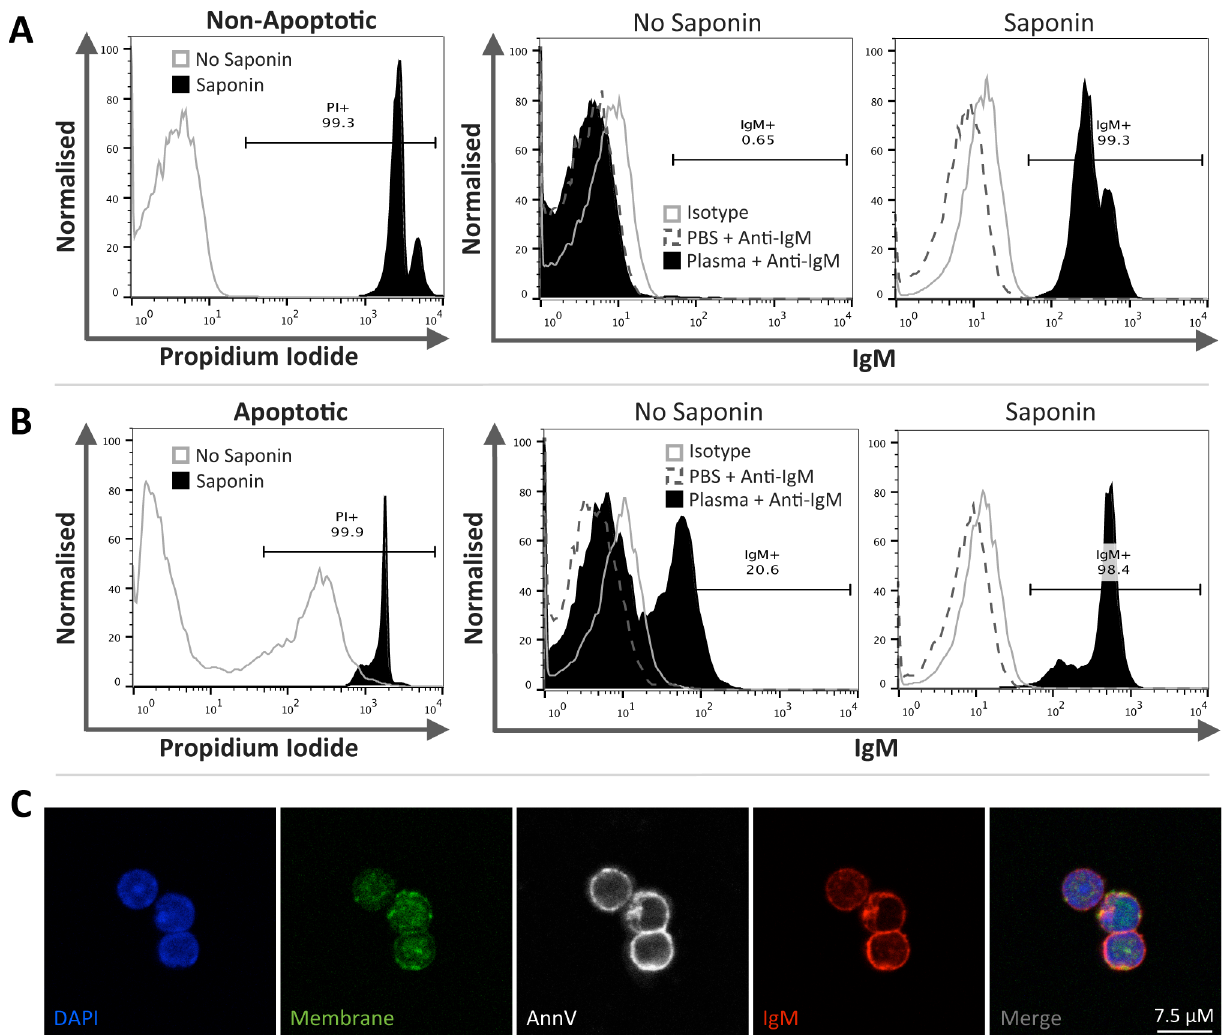
Fig 3. IgM binds strongly to permeabilised non-apoptotic and apoptotic thymocytes. Non-apoptotic and apoptotic mouse thymocytes, induced by overnight culture, were permeabilised with saponin prior to incubation with Balb/c plasma. Permeability was confirmed by PI staining and IgM binding was assessed by flow cytometry. For confocal microscopy AnnV staining was used to indicate permeabilisation A ) Following permeablisation non-apoptotic thymocytes were predominantly PI positive. Non-permeable non-apoptotic thymocytes remained consistently IgM negative, whilst the majority of permeable thymocytes were IgM positive. Inclusion of isotype control IgM antibodies (mouse (Balb/c) IgM κ isotype control) confirmed that IgM binding was not due to a non-specific interaction of IgM. B ) A small proportion of apoptotic thymocytes were PI positive representing late apoptotic thymocytes; however following permeabilisation with saponin the cell population became PI positive. Whilst a minority of apoptotic thymocytes were IgM positive, representing the AnnV + IgM + population discussed in Fig 1C – 1E, with permeabilisation the population became IgM positive. C ) Confocal microscopy demonstrates that permeabilised thymocytes were AnnV positive, used to indicate permeability, with IgM appearing to bind part of the cellular membrane. Representative histograms (Non-apoptotic thymocytes n = 3; Apoptotic thymocytes n = 4). Images were taken using a Leica SP5 with an x63/1.4 objective. Whole image contrast/brightness was adjusted using ImageJ or Adobe